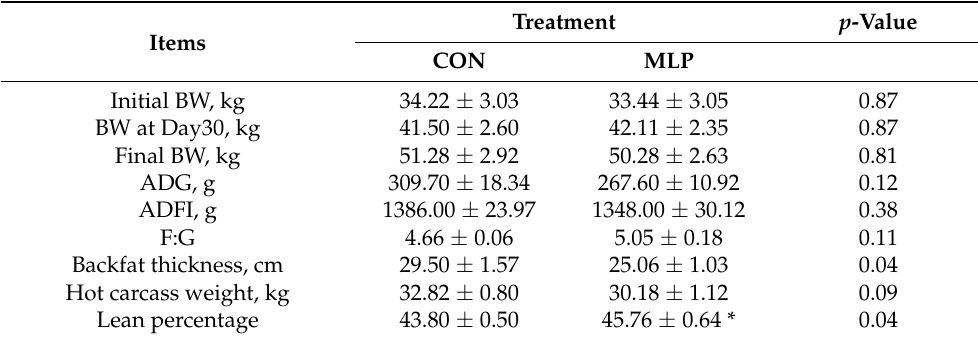
Table 4. Effects of dietary inclusion of mulberry leaf powder on the growth performance and carcass traits of Tibetan pigs.